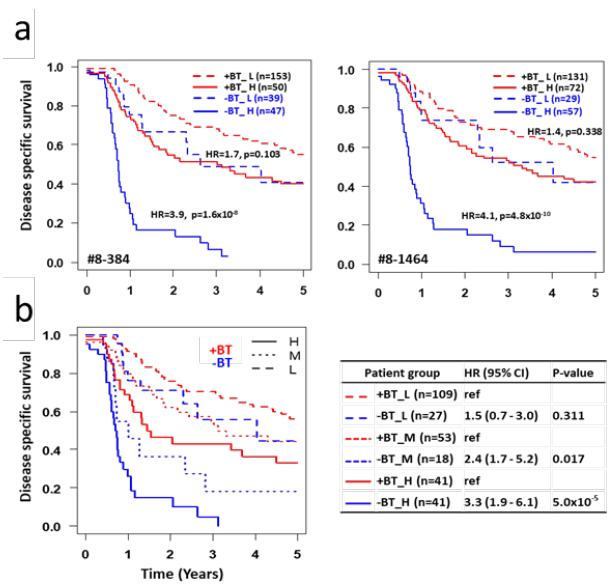
Figure 5. Impact of SASP on response to brachytherapy. ( a ) All stage 3 patients (RTBT3+RT3) were classified into four subsets based on brachytherapy status (+BT and -BT) and SASP status (H vs. L) using cutoffs for each of the 25 RT3 models. Survival curves are shown for all four subsets for two representative models. HR and p values are shown between +BT and -BT subsets within SASP_H or SASP_L subsets. Data for all 25 models are shown in Table S3. ( b ) All stage 3 patients are classified into four subsets based on brachytherapy status and SASP status using plurality voting of all 25 RT3 models. SASP_H: >75% models voted the patient as SASP_H; SASP_L: >75% models voted the patient as SASP_L; SASP_M: <75% of models voted the patient as SASP_H or SASP_L. Data is summarized on the right.